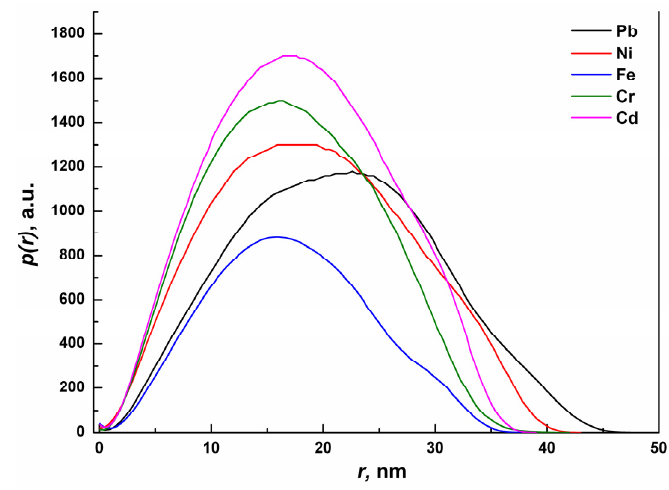
Figure 5. Plots of the experimental pair distance distribution function p (r) versus radial distance r of the KG-metal complexes, as determined by